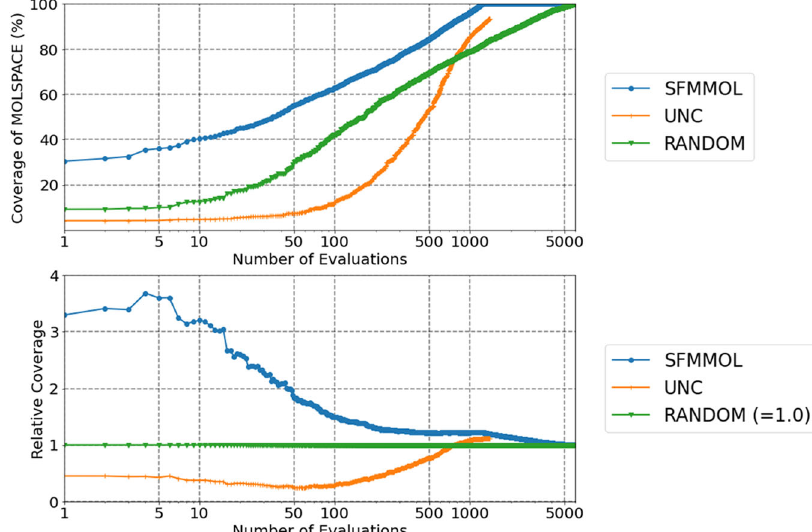
Fig. 4 Accumulated coverages of MOLSPACE. By using SFMMOL, uncertainty sampling (UNC), and random sampling (RANDOM), accumulated coverages of MOLSPACE are displayed as functions of number of evaluations (molecules). Y axis of bottom fi gure represents values relative to those of RANDOM. UNC calculation was terminated at 1400 evaluations due to a technical issue: exceeding the limit of memory usage (>16 Giga bytes). SFMMOL remarkably improved coverages, especially in smaller number of evaluations (<100), whilst UNC drastically increased as number of evaluations approached